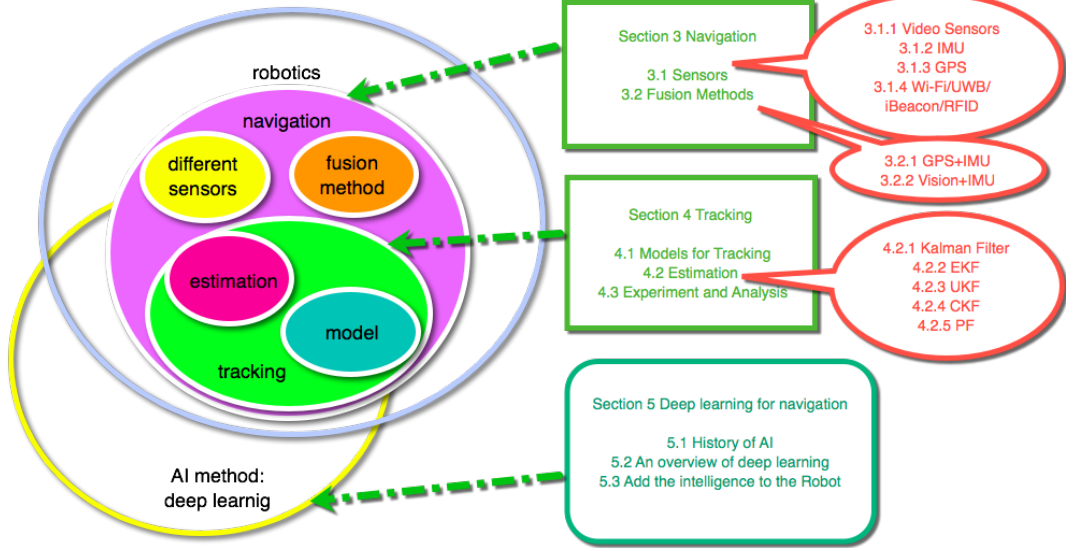
Figure 1. The organization of this